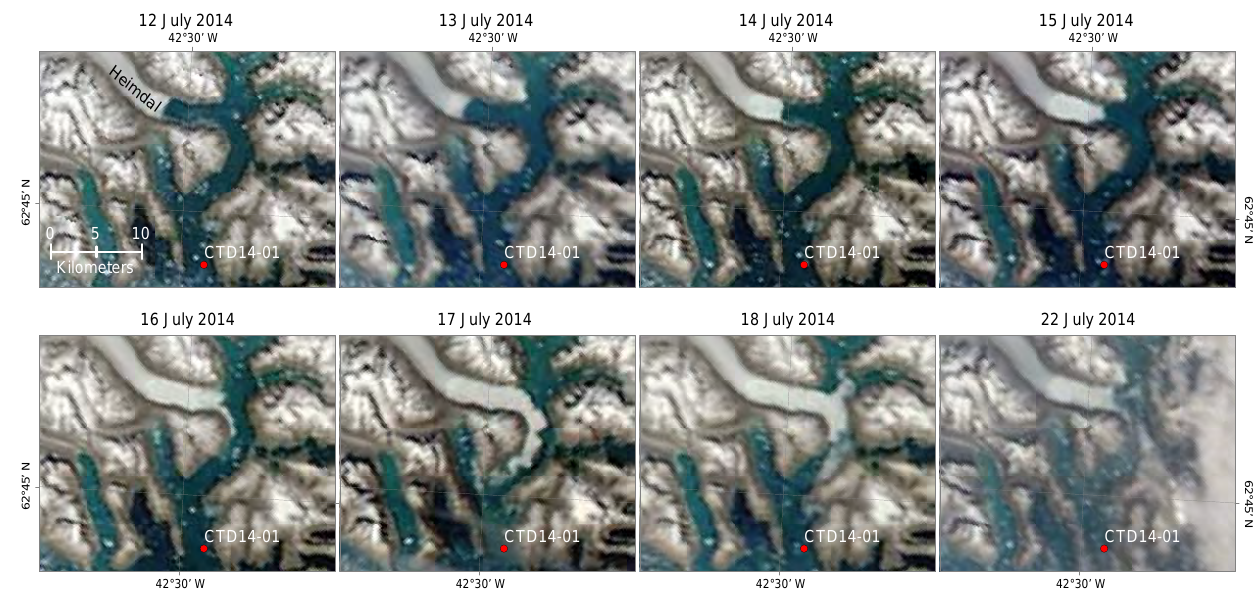
Figure 7. MODIS imagery of the inner part of the branch of Timmiarmiut Fjord that leads towards Heimdal at the head. The imagery illustrates the distribution of ice mélange set into motion on 13 July near the calving front of Heimdal Glacier due to the release of subglacial meltwater. During the following days the ice mélange expands and is directed southwards. In our CTD measurements on 18 July from CTD14-01, we detect this as a cooling and an increase in the salinity of the layer between 10 and 50m of depth.